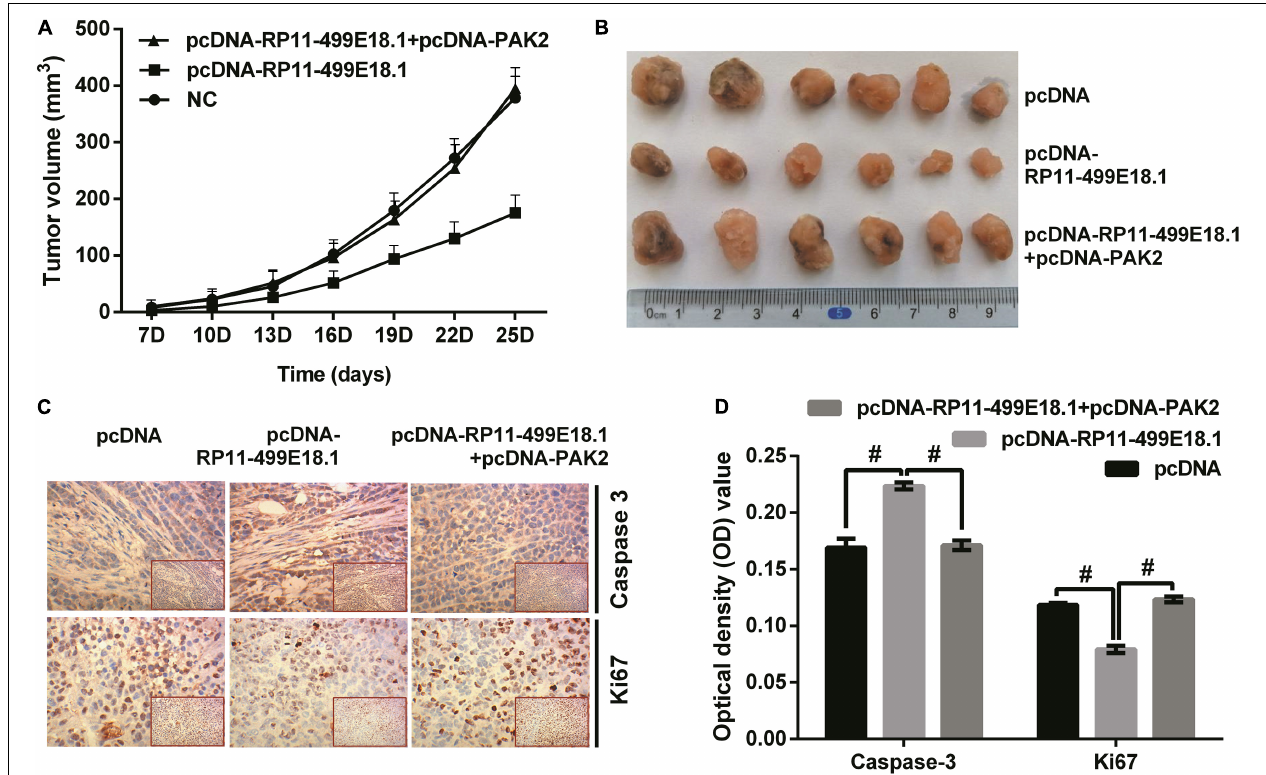
FIGURE 8 | PAK2 upregulation reversed RP11-499E18.1 overexpression-induced facilitating effects on tumor formation. The plasmids pcDNA3.1, pcDNA-RP11-499E18.1, and pcDNA-RP11-499E18.1 + pcDNA-PAK2 were respectively, transfected into CaOV3 cells. Then, the transfected cells were respectively inoculated at the right dorsal proximal upper limbs of nude mice. (A,B) RP11-499E18.1 overexpression remarkably inhibited tumor growth as time prolongs, while PAK2 upregulation notably reversed this effect. (C,D) RP11-499E18.1 overexpression remarkably increased the expression of apoptosis-related Caspase 3, while notably decreased the expression of proliferation-associated Ki67. These effects were notably counteracted by PAK2 upregulation. PAK2, P21 (RAC1) activated kinase 2. # p < 0.05.